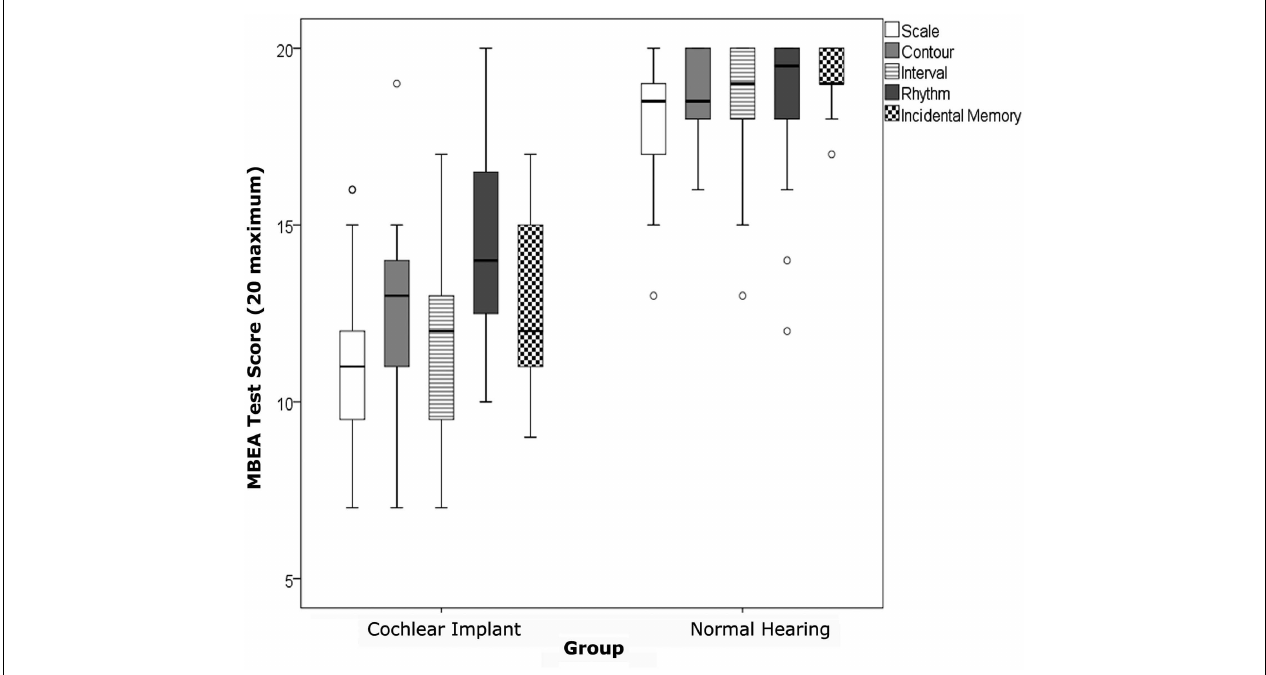
tests were significantly better in the normal hearing group compared to the cochlear implant group.The cochlear implant group were most accurate on the Rhythm